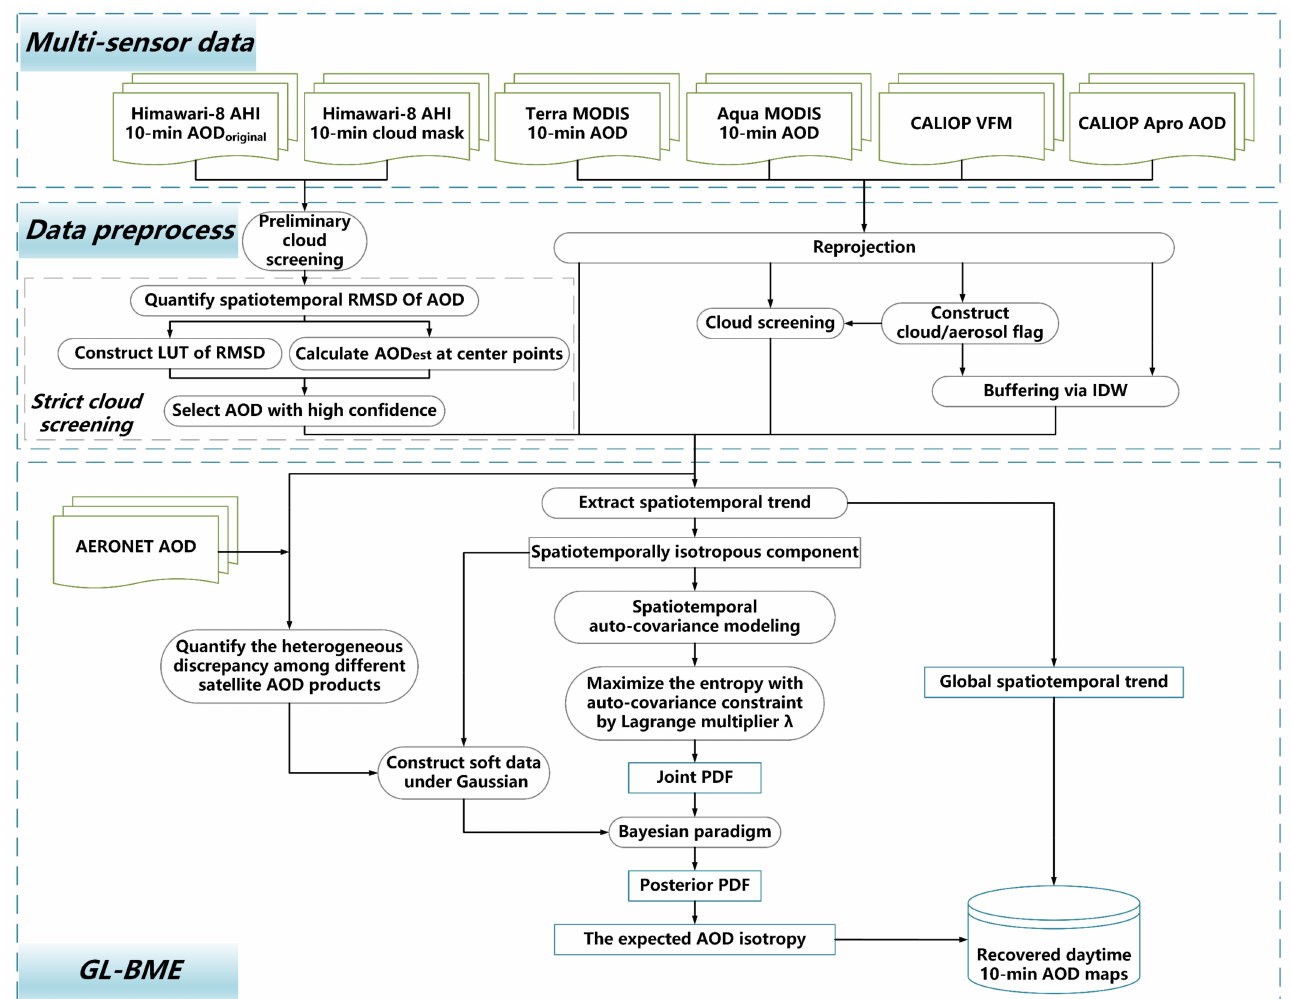
Figure 2. Flowchart of the AOD fusion by integrating LEO and GEO AOD products. (RMSD and PDF are the abbreviations of root-mean-square difference and probability density function,